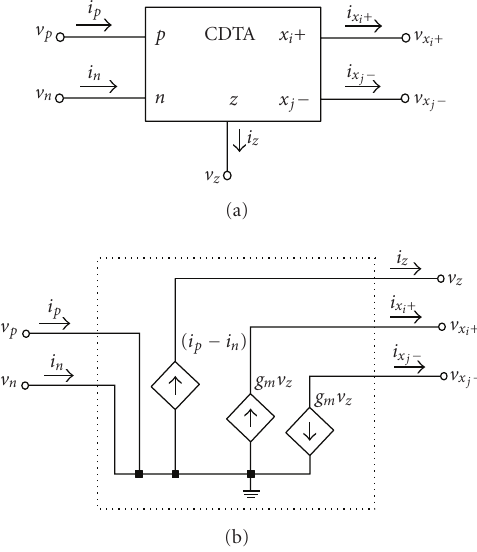
Figure 1: (a) Circuit symbol of CDTA. (b) Equivalent circuit of